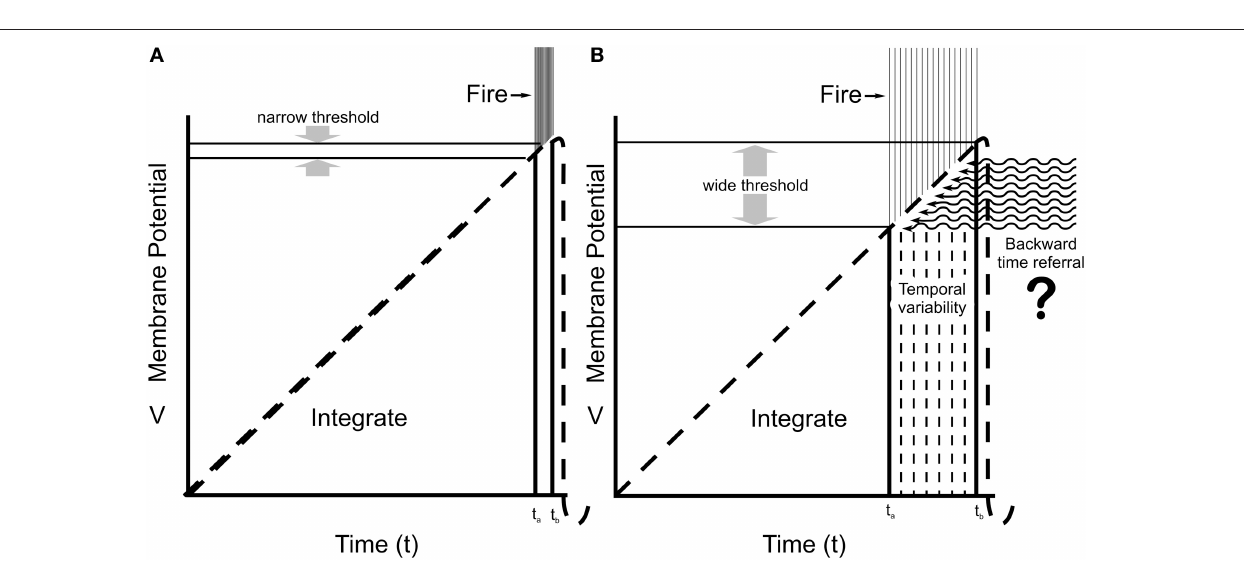
FIGURE 2 | Integrate-and-fire neuronal behaviors. (A) The Hodgkin–Huxley model predicts integration by membrane potential in dendrites and soma reach a specific, narrow threshold potential at the proximal axon (AIS), and fire with very low temporal variability (small t b – t a ) for given inputs. (B) Recordings from cortical neurons in awake animals